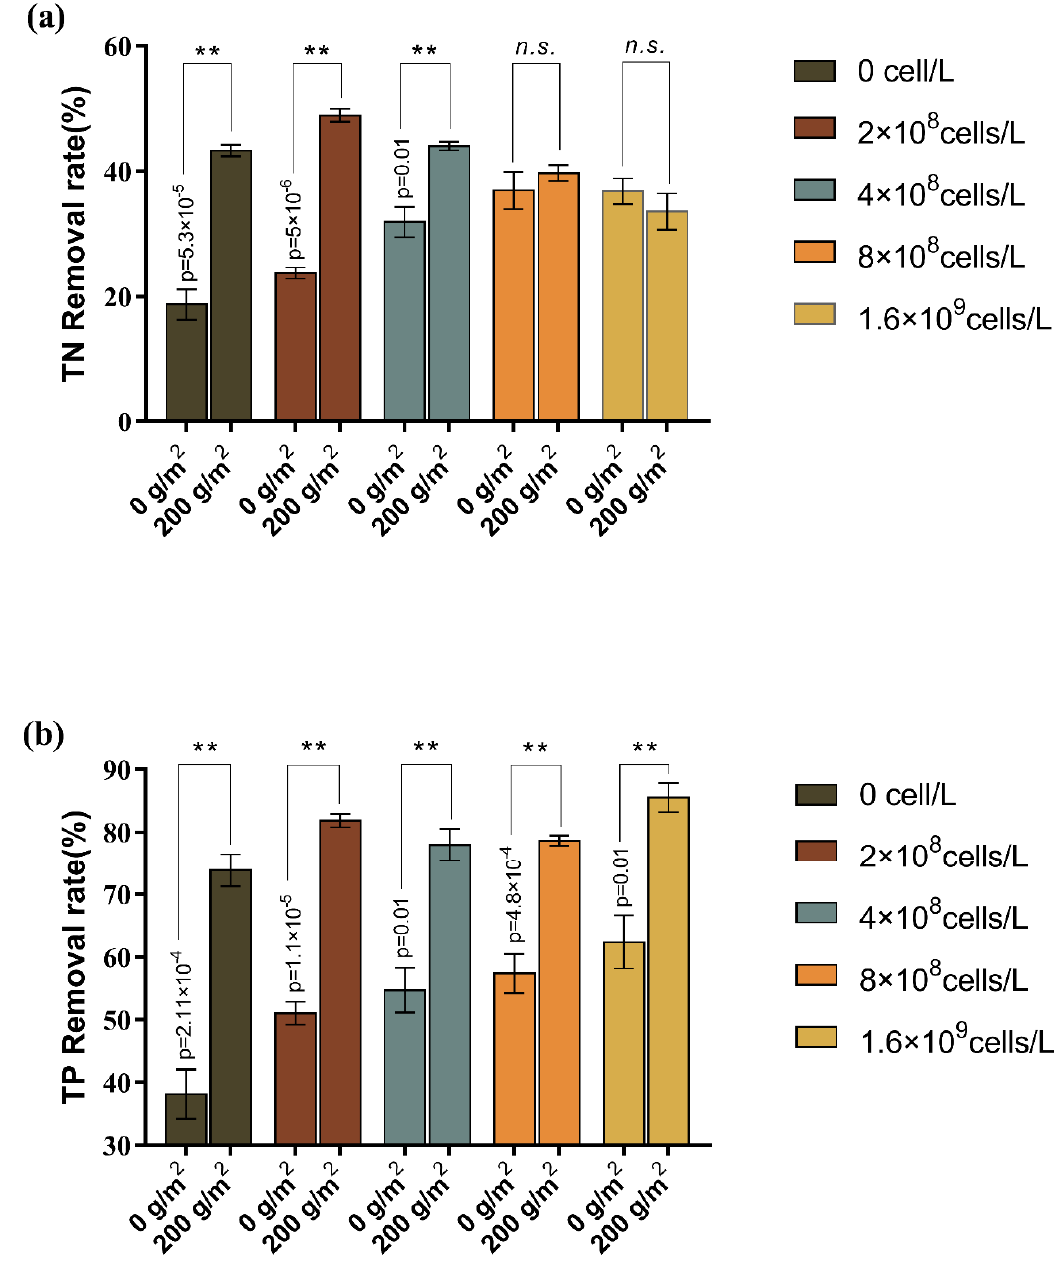
Figure 6. Total nitrogen (TN) and total phosphorus (TP) removal rate by L. punctata . ( a ) TN removal rate. ( b ) TP removal rate. Values are means ± SE from three biological replicates. Asterisks indicate statistical significance based on Student’s t test; ** p < 0.01, n.s. indicates no significance.